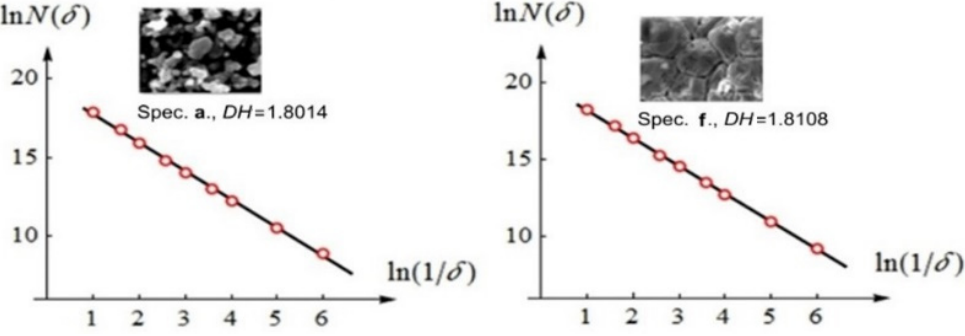
Figure 10. Fractal dimensions of specimens.